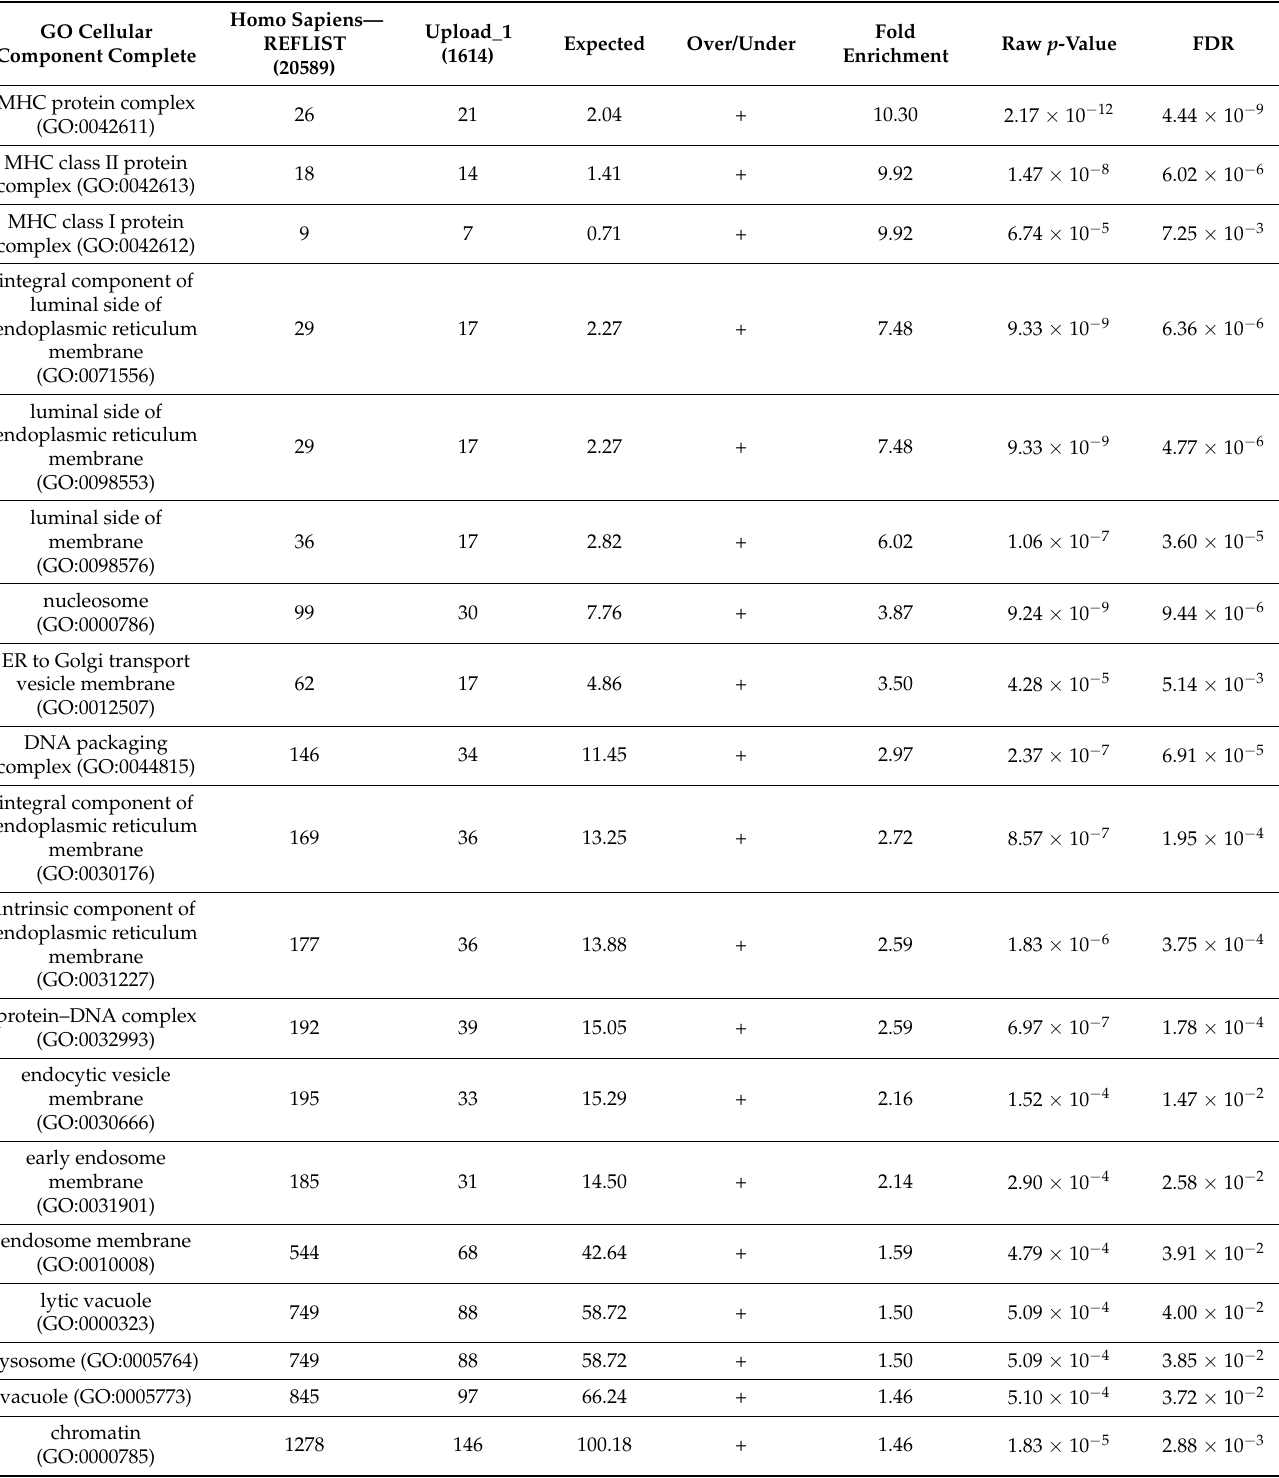
Table 5. GO cellular components in 122 CRC patients with CNAs in HDAC2